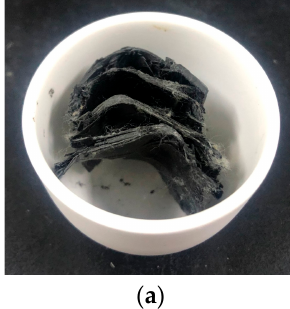
Figure 7. SEM ‐ EDS observation results of the recycled CFRP fragment. ( a ) Image of the CFRP Figure 7. SEM-EDS observation results of the recycled CFRP fragment. ( a ) Image of the CFRP after after MAP treatment ; ( b ) SEM (3000 × ) ; ( c ) EDS . MAP treatment; ( b ) SEM (3000 × ); ( c ) EDS.